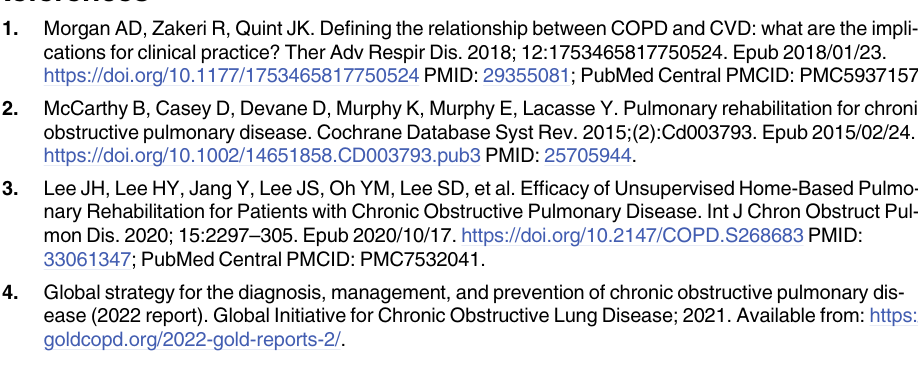
S2 Table. Prevalence of baseline respiratory symptoms overall and in never smokers, and according to cardiovascular causes of death. S3 Table. After exclusion of patients with known heart disease. Hazard ratios with 95% con- fidence intervals and p-values according to cause of death, multivariable proportional hazards regression analysis adjusted for sex, education, occupational exposure to gas/dust and birth cohort (n = 90,316). S4 Table. After exclusion of patients with known heart disease or lung disease. Hazard ratios with 95% confidence intervals and p-values according to cause of death, multivariable proportional hazards regression analysis adjusted for sex, education, occupational exposure to gas/dust and birth cohort (n =